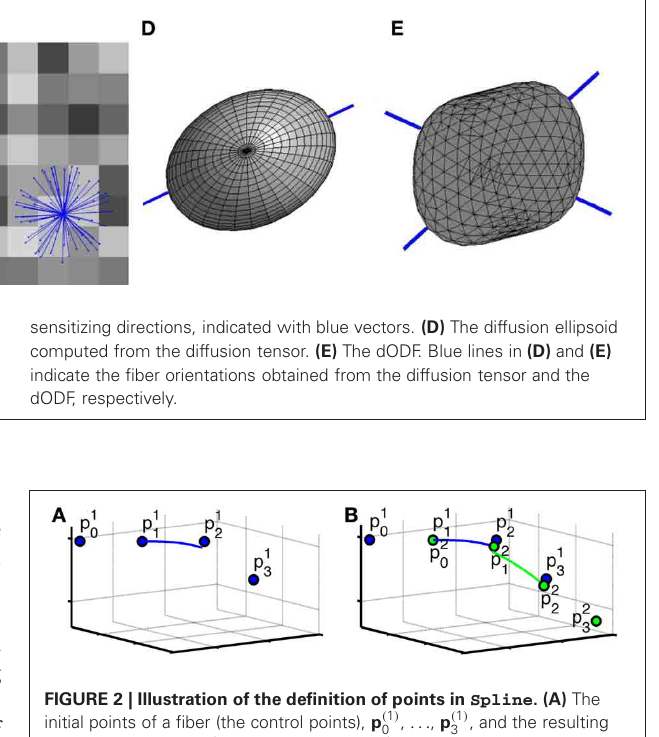
FIGURE 2 | Illustration of the definition of points in Spline . (A) The initial points of a fiber (the control points), p ( 1 ) 0 , ... , p ( 1 ) 3 , and the resulting spline (blue curve). p ( 1 ) 1 is the seed point, p ( 1 ) 2 is found by going a step-length in the direction of a local maxima in p ( 1 ) 1 , p ( 1 ) 0 is found by going in the opposite direction, and p ( 1 ) 3 is found by going a step-length in the direction of the local maxima most closely to the incoming direction in p ( 1 ) 2 . (B) The second iteration. p ( 2 ) 0 , ... , p ( 2 ) 3 , and the resulting spline. The